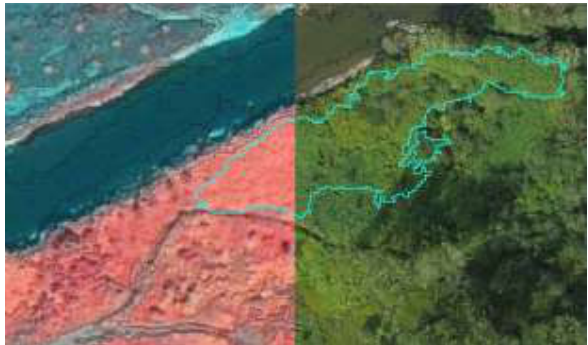
Figure 10. Pleiades 1B (false color composite of NIR-G-B, July 2015) vs. UAV (RGB, August 2015) imagery with segmented objects, blue outlines a knotweed patch identified from Pleiades